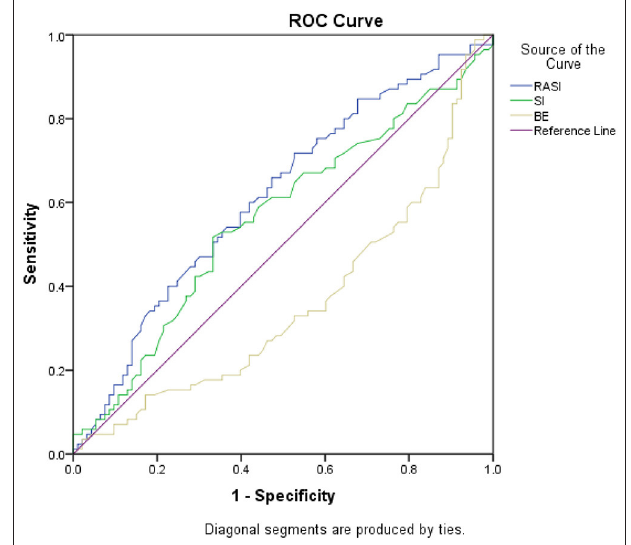
FIGURE 4 | Patient survival analysis Based on SI quarters.